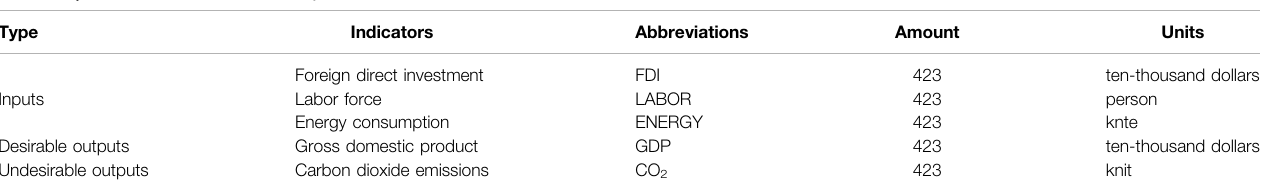
TABLE 2 | The measurement indicators